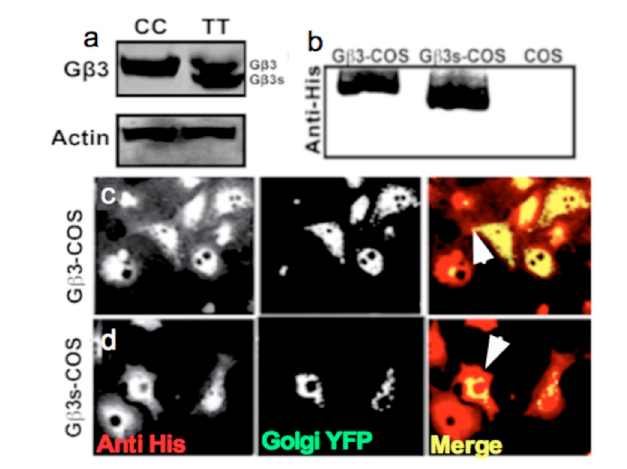
Figure 1. Expression of Gβ3 and Gβ3s subunits. CC and TT lymphoblast cell lysates were immuno blotted with custom raised GNB3 antibody to determine Gβ3 and Gβ3s protein expression levels respectively (a). Protein lysates forming stable COS-7 clones were analyzed for the expression of His tagged Gβ3 and Gβ3s upon immunoblotting with Anti-Histidine (his) antibody (b). Data presented here is of n = 3 independent experiments. No localisation difference between His tagged Gβ3s and Gβ3 subunit was observed when immune probed with Anti-his in stable clones transfected with Golgi-YFP in both untreated and EGF stimulated condition (c-d). These images are taken from different fields of view under a 40x objective with further 1.5x